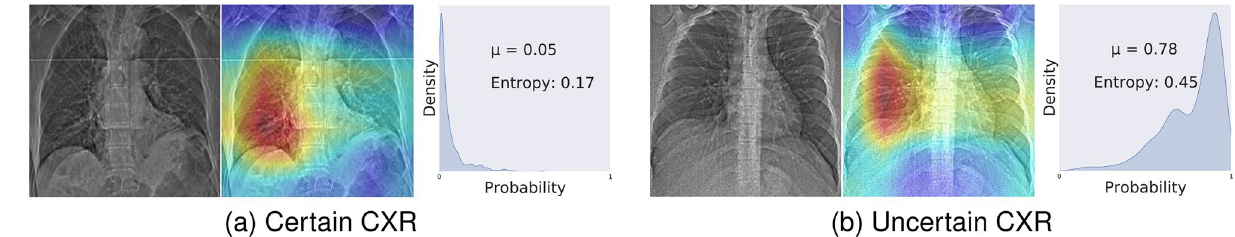
Figure 4. Two healthy (normal) images and their approximate predictive posterior distributions. These distributions, p ( covid | image ), are estimated by the MCD algorithm. ( a ) Correct and certain prediction, ( b ) incorrect and uncertain prediction. The middle plot in each row shows where DNNs look for making the decision.